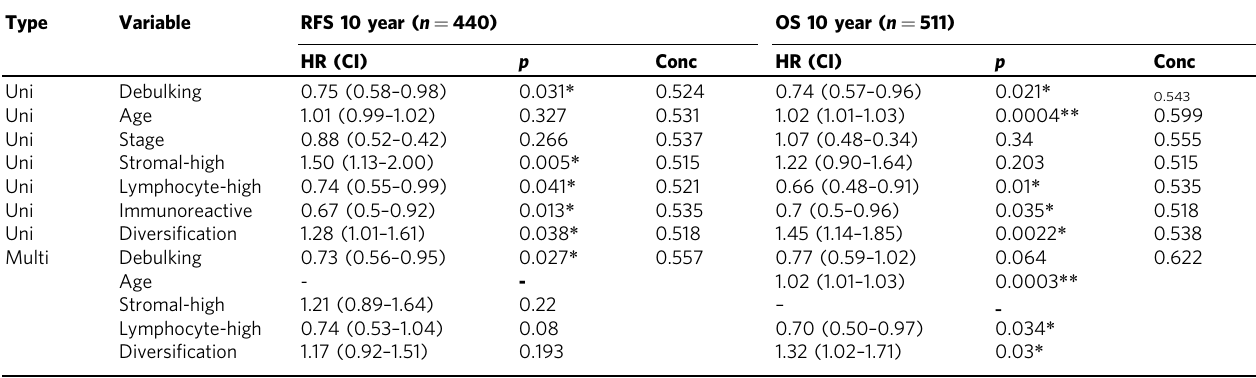
Diversi fi cation, patients with at least one diversi fi cation zone; Uni, univariate Cox regression; Multi, multivariate Cox regression; Conc, concordance; HR, hazard ratio; CI, con fi dence interval * p <0.05; ** p <0.01